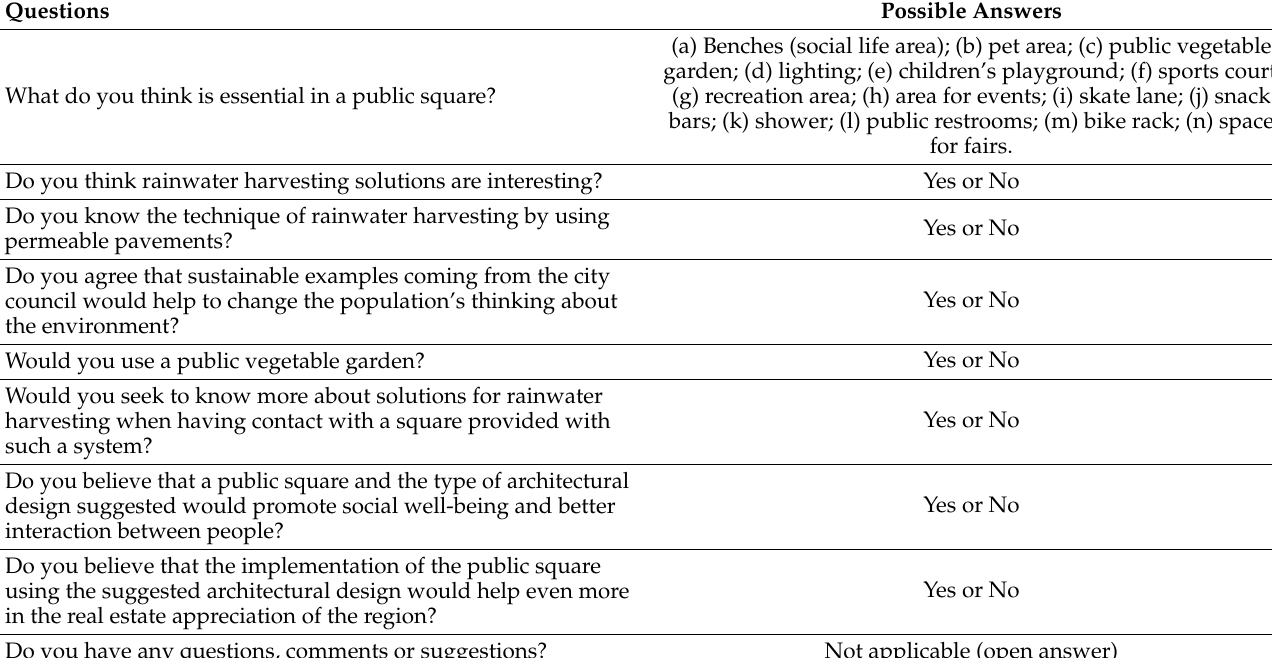
Table 1. Questions and possible answers of the questionnaire applied in the study.